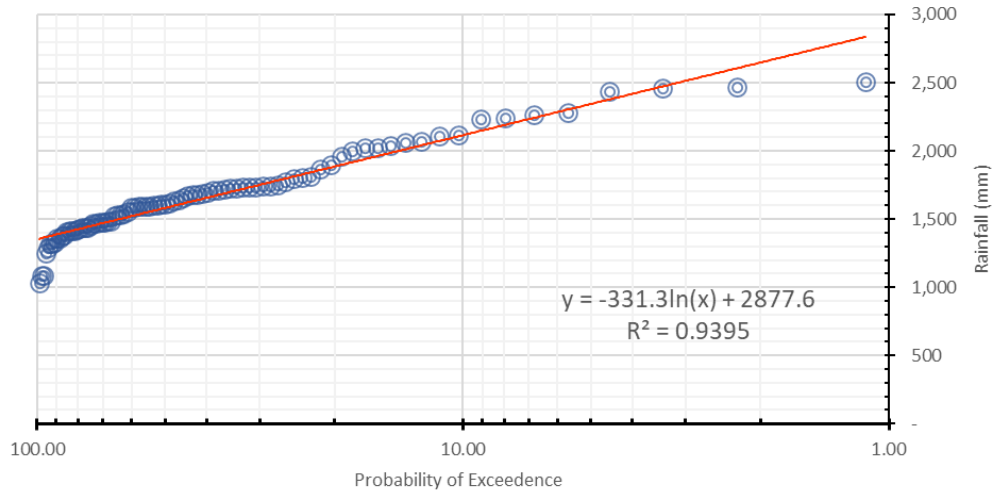
Figure 3. Dependable rainfall in Kilombero river catchment.